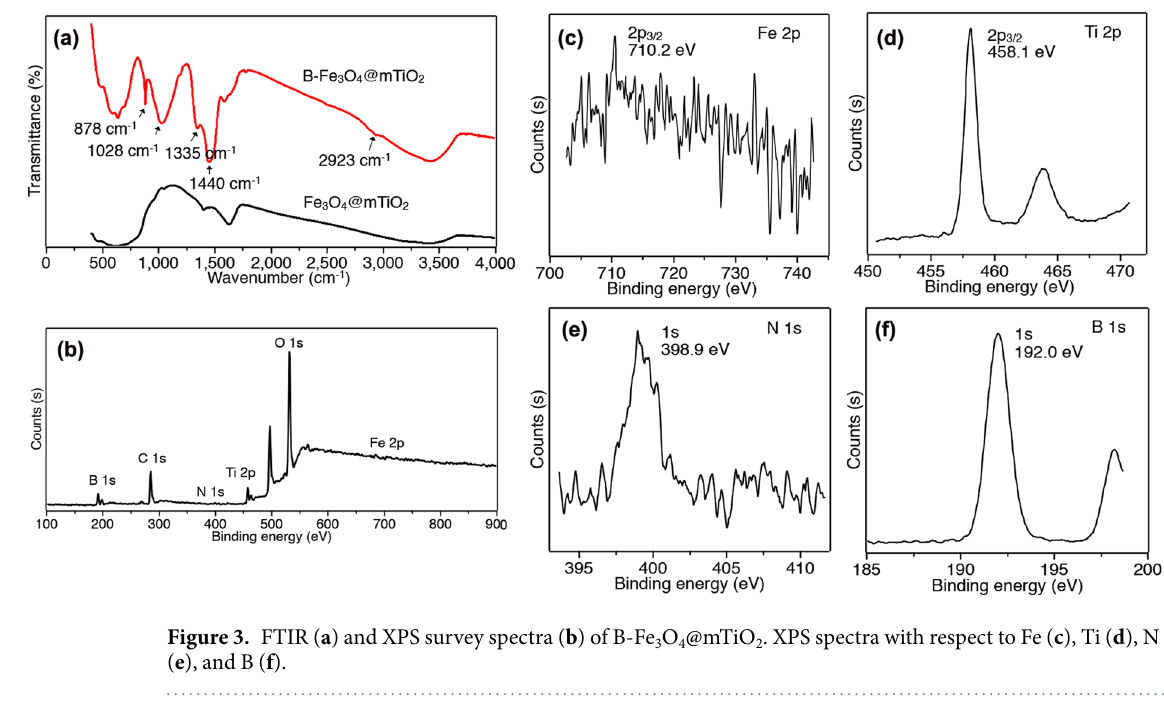
Figure 3. FTIR ( a ) and XPS survey spectra ( b ) of B-Fe 3 O 4 @mTiO 2 . XPS spectra with respect to Fe ( c ), Ti ( d ), N ( e ), and B ( f ).